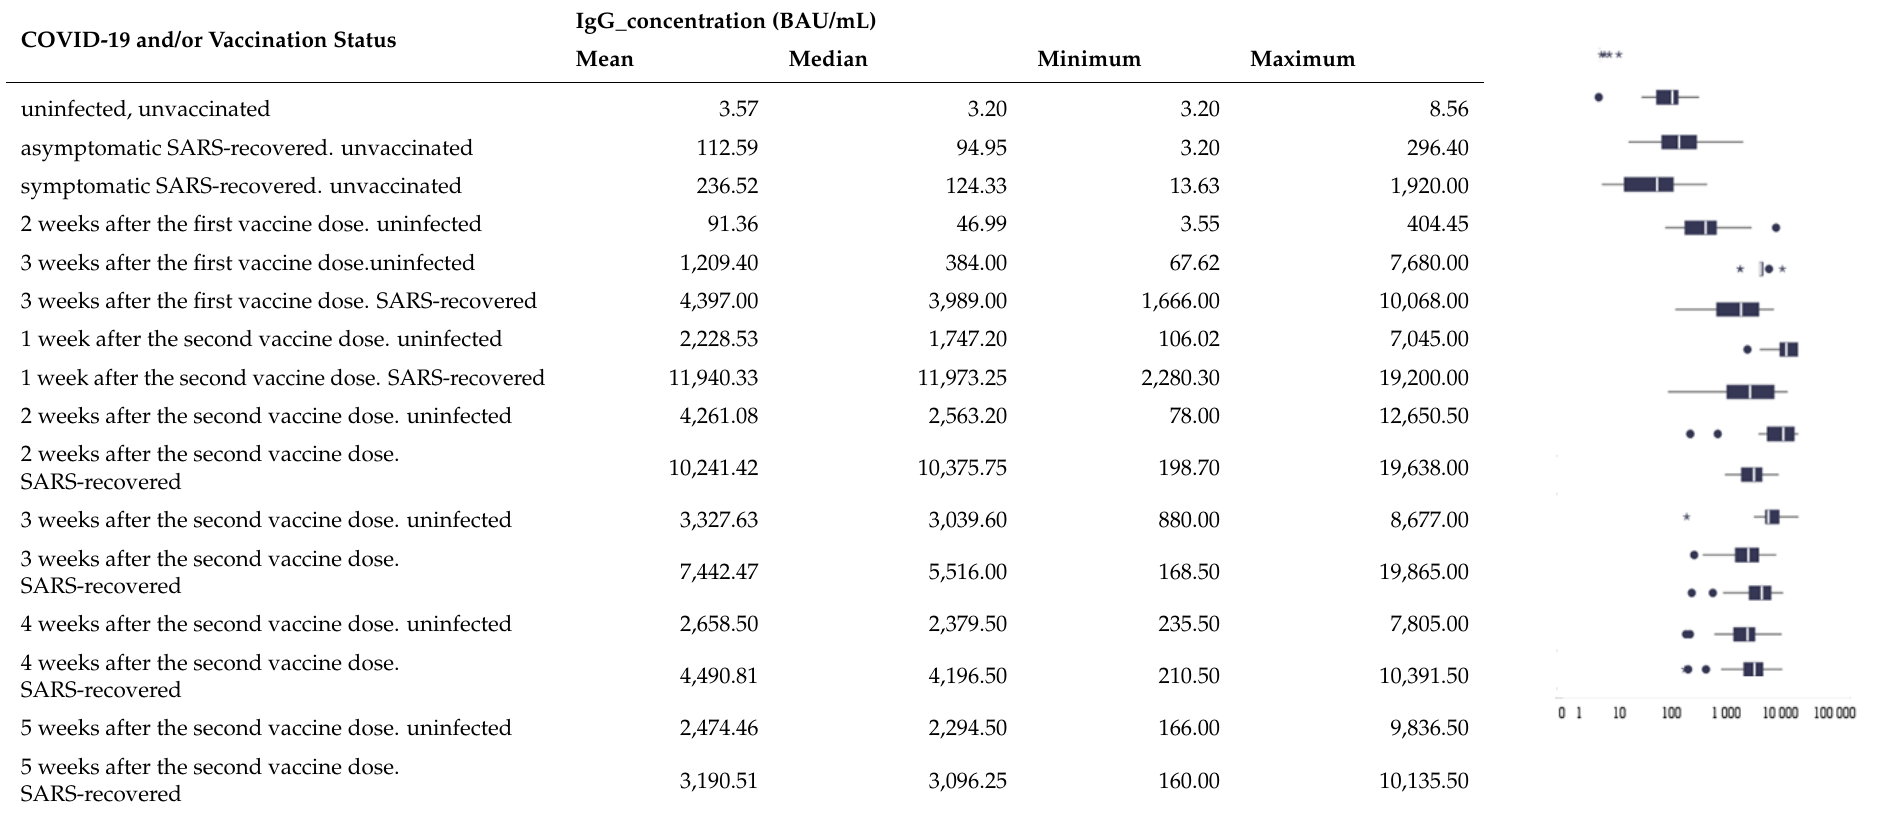
Table 2. Median, maximum, and minimum concentrations of anti-SARS-CoV-2 IgG antibodies in the compared subgroups.